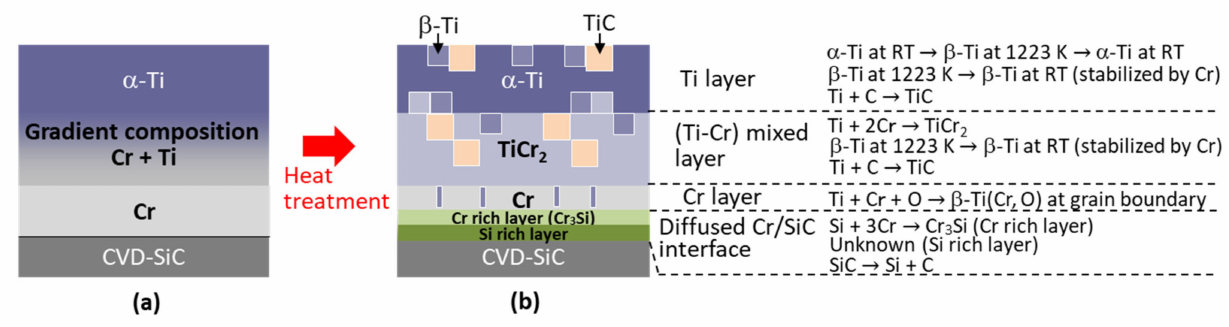
Figure 1. Cross-sectional illustrations of ( a ) the PVD Ti-Cr multilayer coating and ( b ) its transition after heat treatment at 1223 K for 1.8 × 10 3